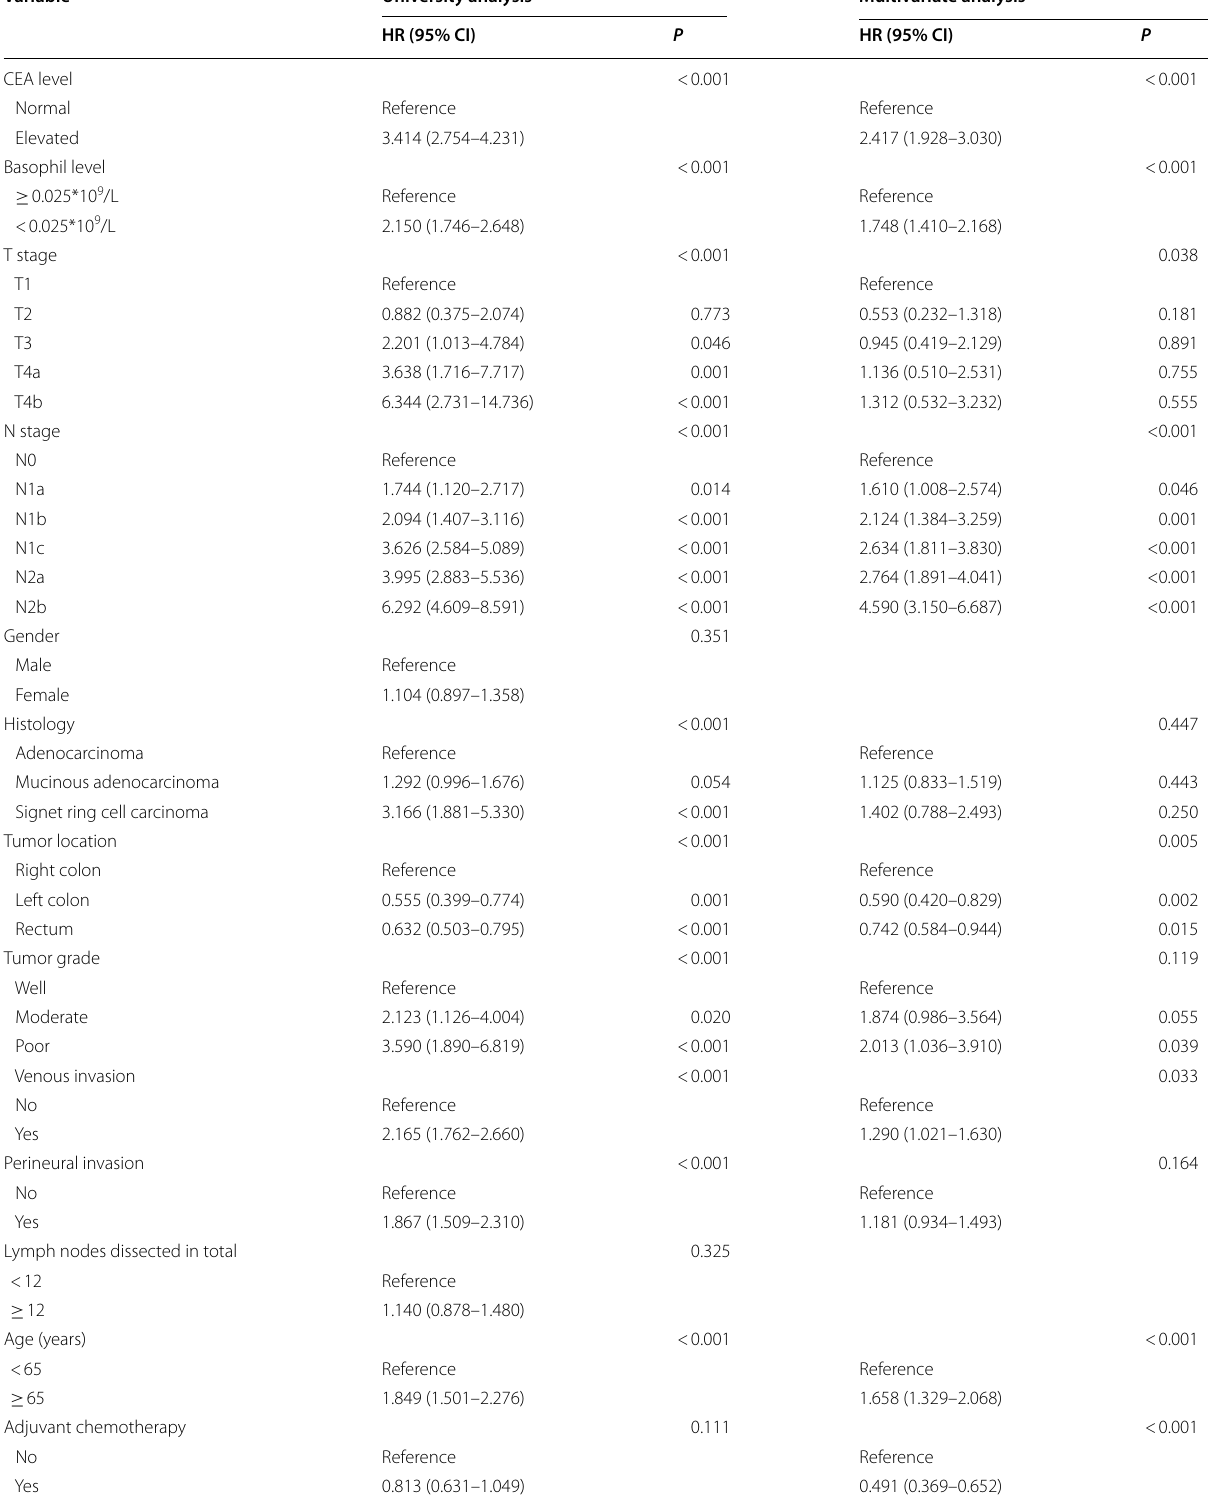
Table 2 Univariate and multivariate Cox analyses of OS in the whole cohort